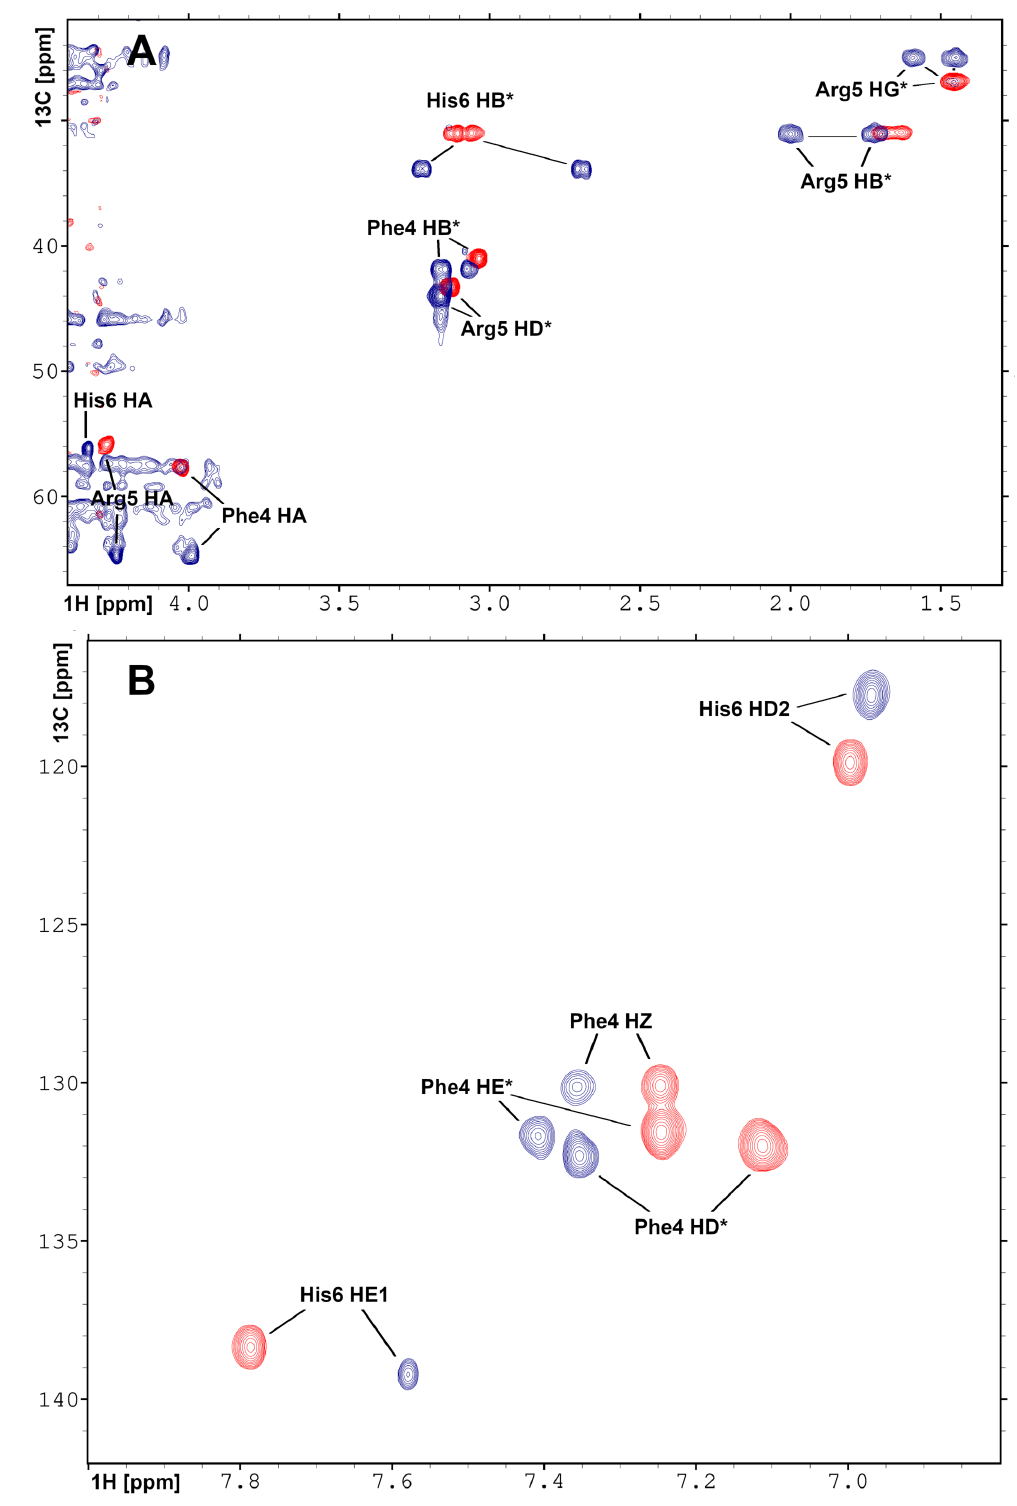
Figure 4. Overlay of the 2D heteronuclear 1 H- 13 C HSQC NMR spectra recorded for ( A ) aliphatic and ( B ) aromatic regions for A β 4 − 6 peptide in apo (red) and Pd(II) saturated (blue) forms. The assignments and changes in the position of the resonances are shown. The experiments were performed on Varian Inova 500 NMR